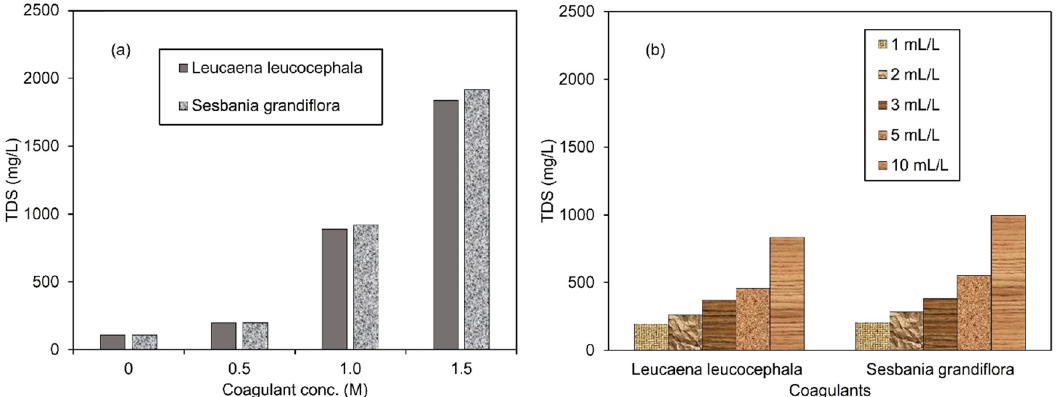
Figure 6: TDS removal on arti fi cial turbid water with L. leucocephala and S. grandi fl ora based on coagulant concentration ( a ) and dosage ( b )